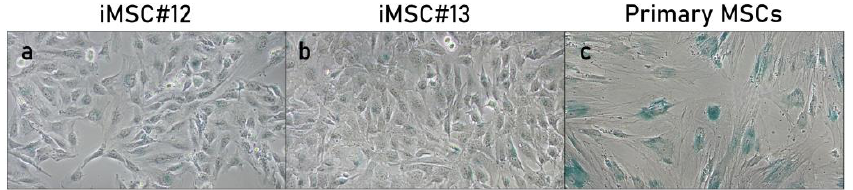
Figure 2. SA-ß-Gal stained iMSC#12 ( a ), iMSC#13 ( b ) and primary MSCs at the fourthpassage ( c ). Images obtained by phase contrast microscope. SA-ß-Gal activity is shown in blue. Magnification: 100×.